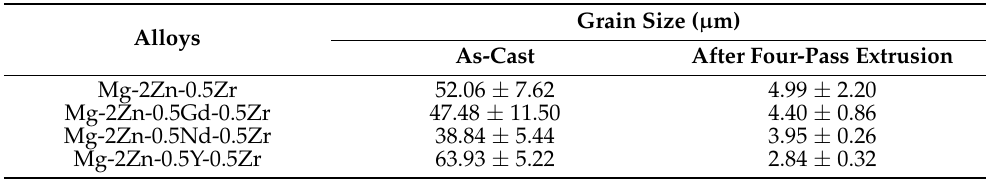
Figure 3. Optical microstructure of the alloys: ( a , b ) the as-cast and the four-pass extruded Mg-2Zn-0.5Zr alloy; ( c , d ) the as-cast and the four-pass extruded Mg-2Zn-0.5Gd-0.5Zr alloy; ( e , f ) the as-cast and the four-pass extruded Mg-2Zn-0.5Nd-0.5Zr alloy; ( g , h ) the as-cast and the four-pass extruded Mg-2Zn-0.5Y-0.5Zr alloy. Table 3. Grain size of the alloys before and after extrusion.